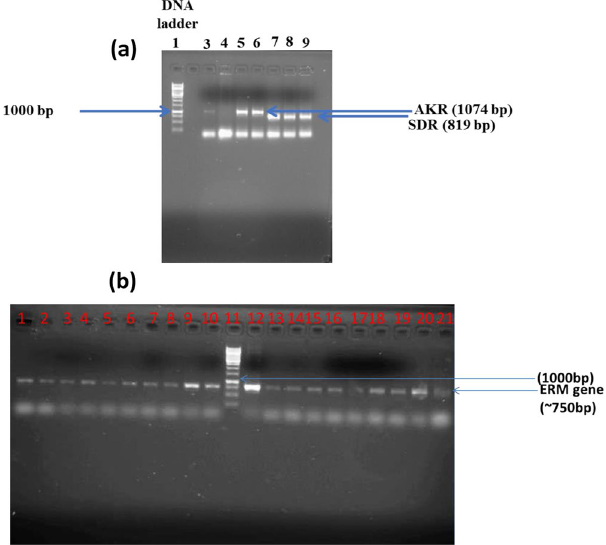
Figure 12. PCR amplification of respective constructs following extraction of recombinant plasmids from respective E. coli TOP 10 transformants. ( a ) AKR ( Cbei_3974 ) and SDR ( Cbei_3904 ) amplicons following PCR amplification with pMTL-JH16_3974 (lanes 4, 5 and 6) and pMTL-JH16_3904 (lanes 8 and 9) extracted from E. coli TOP 10 transformants as template. Lanes 3 and 7: positive controls, where lane 3 is the PCR amplicon using pMTL-JH16_3974 before transformation (into E. coli ) as template, while lane 7 is the PCR amplicon using pMTL-JH16_3904 before E. coli transformation as template. ( b ) Gel image showing PCR amplicons of erythromycin resistance gene using genomic DNA extracted from Cb colonies transformed with pMTL-JH16_3904 (lanes 1–10) and pMTL-JH16_3974 (13–21). Lane 12: erythromycin resistance gene positive control. Lane 11: DNA ladder. The gel images were cropped for clarity and the full-length gels are presented in Fig.